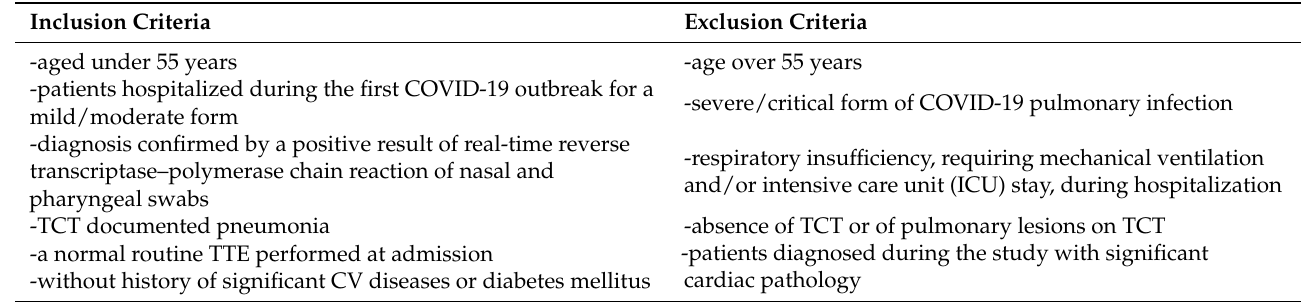
Table 1. Inclusion and exclusion